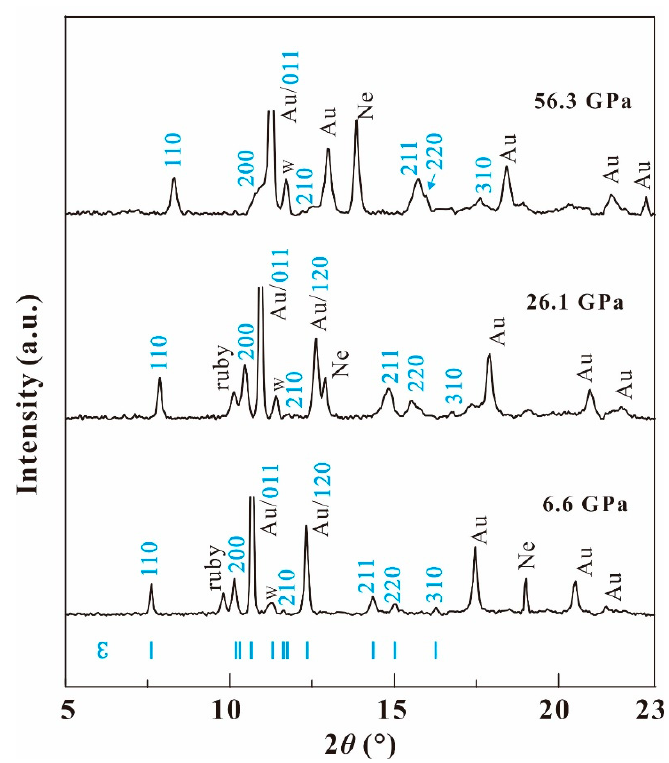
Figure 2. Selected x-ray diffraction patterns of compressed ε -FeOOH in Ne.